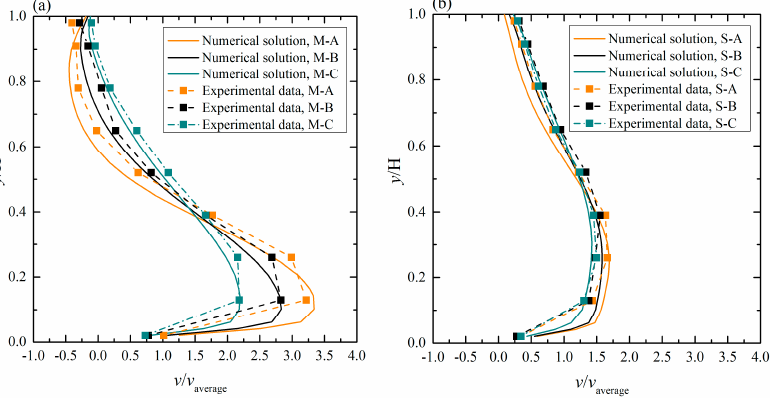
Figure 9. Validation for the velocity distribution in the outflow condition: ( a ) middle orifice; ( b ) side orifice.